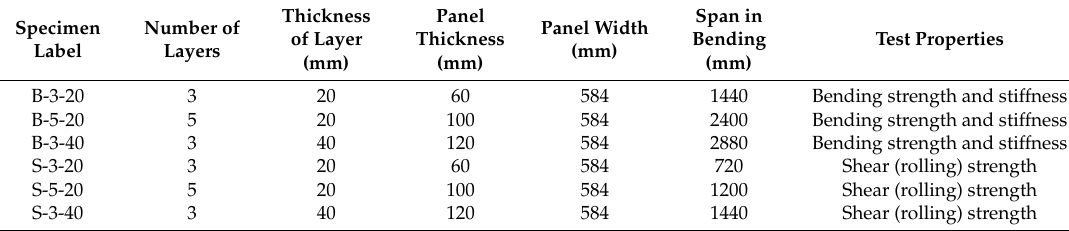
Table 1. Test panel configuration and determined properties.